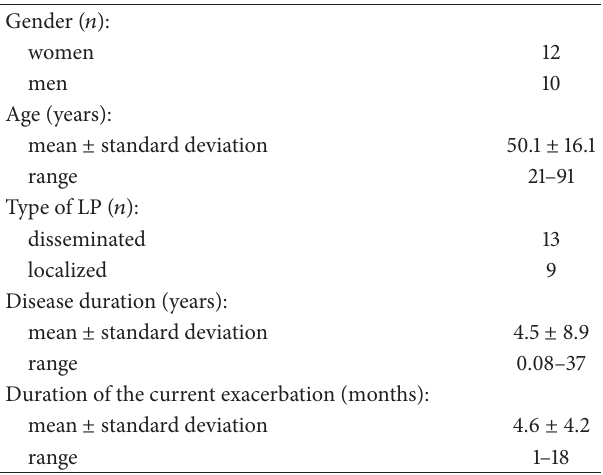
Table 1: Demographic and clinical characteristics of enrolled patients with lichen